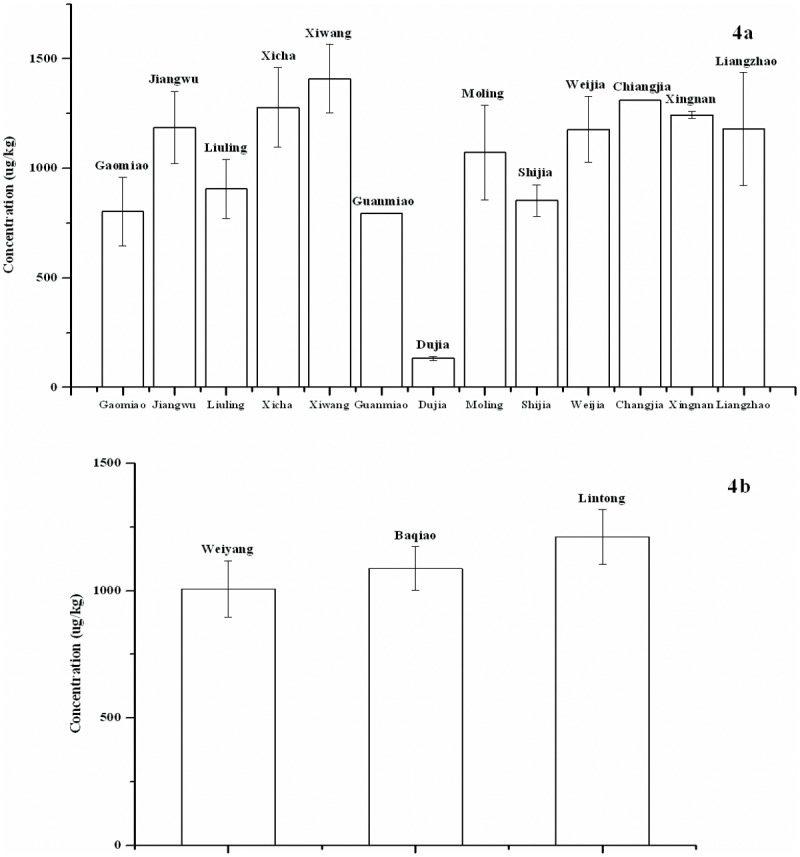
PAHs in vegetation among 13 sampling areas (a) and three regions (b).